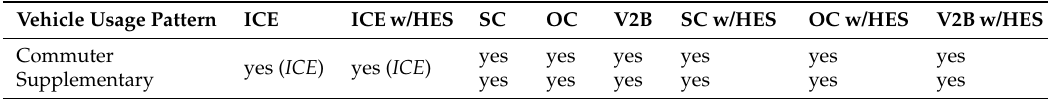
Table 3. Overview of the fourteen simulated scenarios with three different charging schemes, two vehicle usage patterns, and either one or two BESSs within the prosumer household.